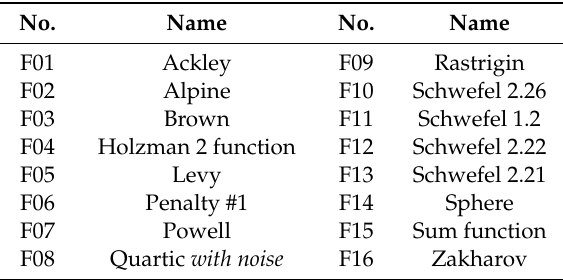
Table 1. Sixteen benchmark